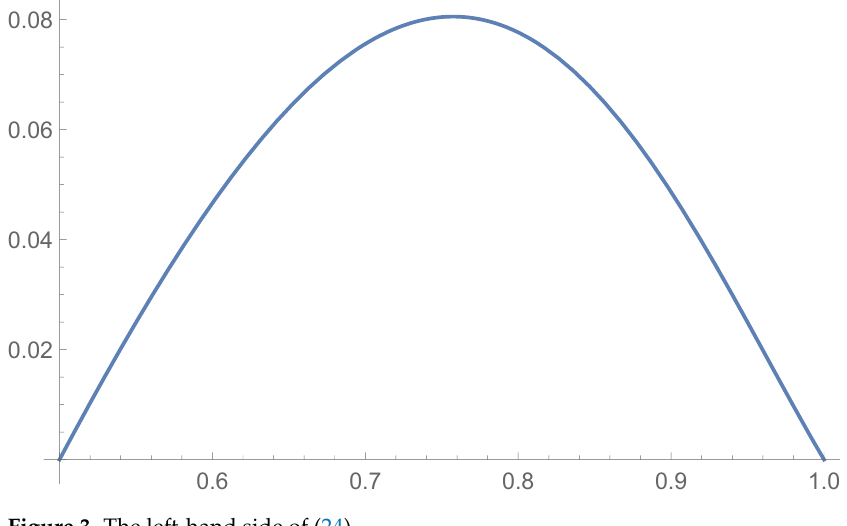
Figure 3. The left-hand side of